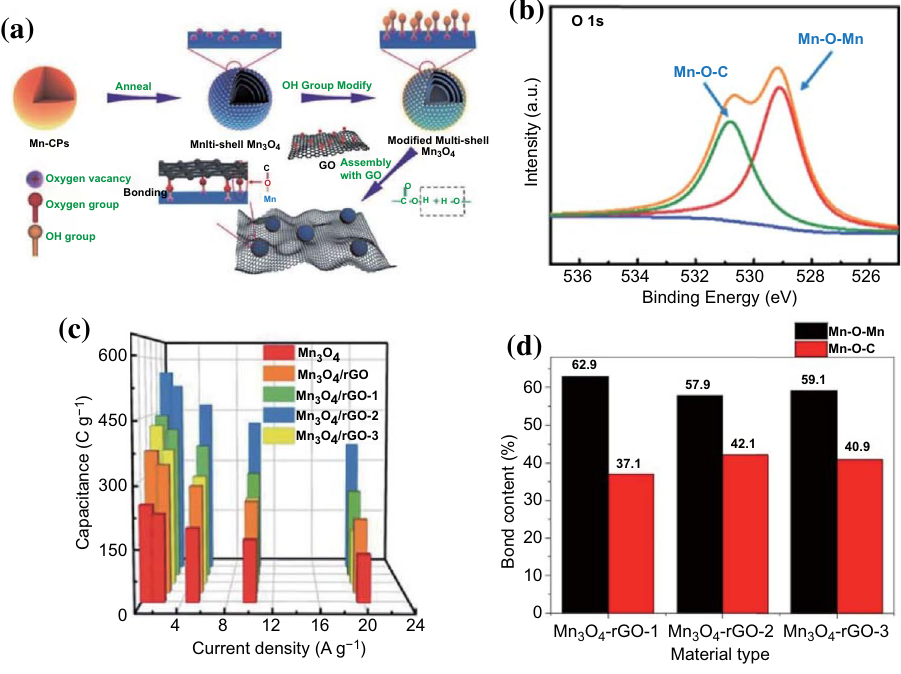
Fig. 9 a Schematic illustration for the fabrication of Mn 3 O 4 -rGO. b O 1s core-level spectra of Mn 3 O 4 -rGO. c The specific capacitance of all samples at different current densities. d Contents of Mn–O–C and Mn–O–Mn in all Mn 3 O 4 -rGO samples. Adapted with permission from